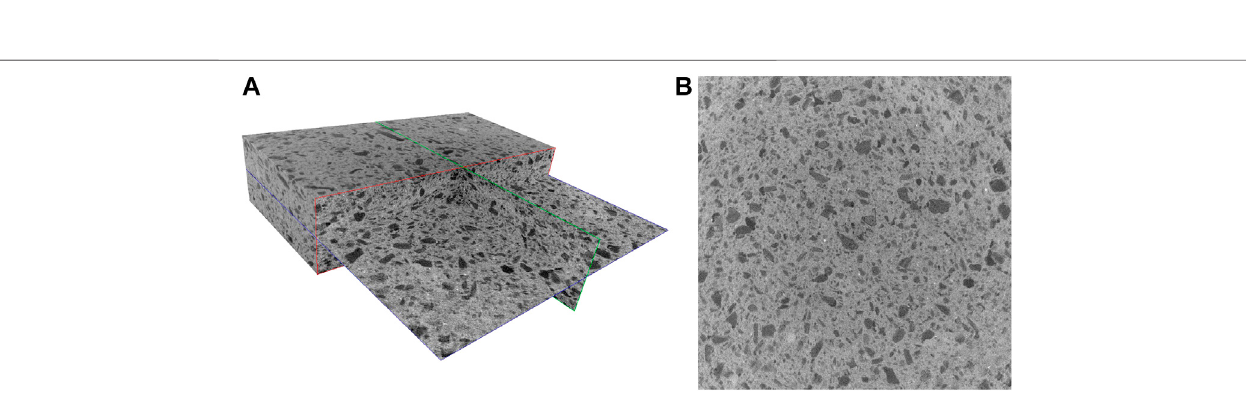
FIGURE 2 | 3D microCT render (A) and representative slice (B) of the composite A30%. The volume has a dimension of 20.6 × 20.6 × 4.8 mm 3 .